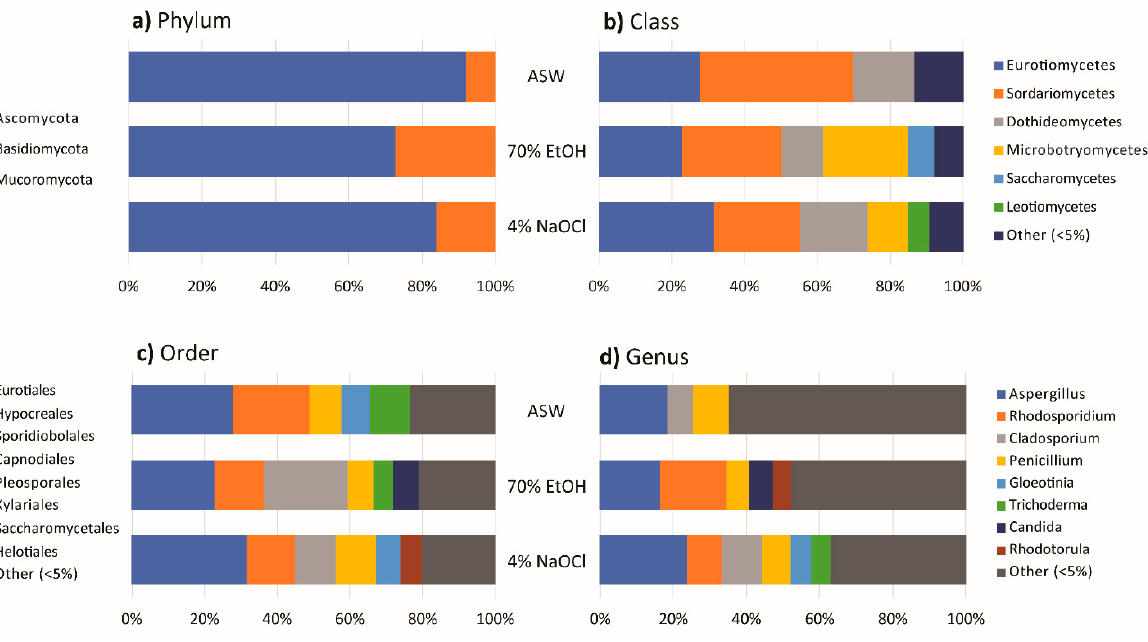
Figure 8. Bar chart showing diversity of fungi at the ( a ) phylum, ( b ) class, ( c ) order, and ( d ) genus levels of thalli sterilized with artificial seawater (ASW), 70% ethanol (70% EtOH), and 4% sodium hypochlorite (4% NaOCl).